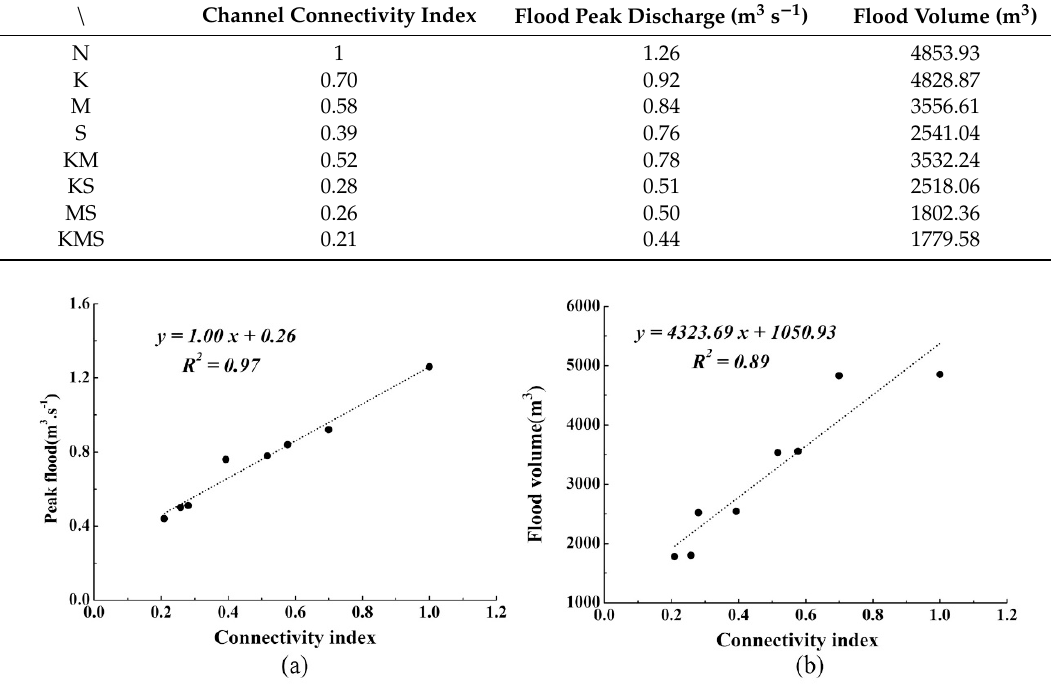
Table 6. Channel connectivity index under different working conditions.